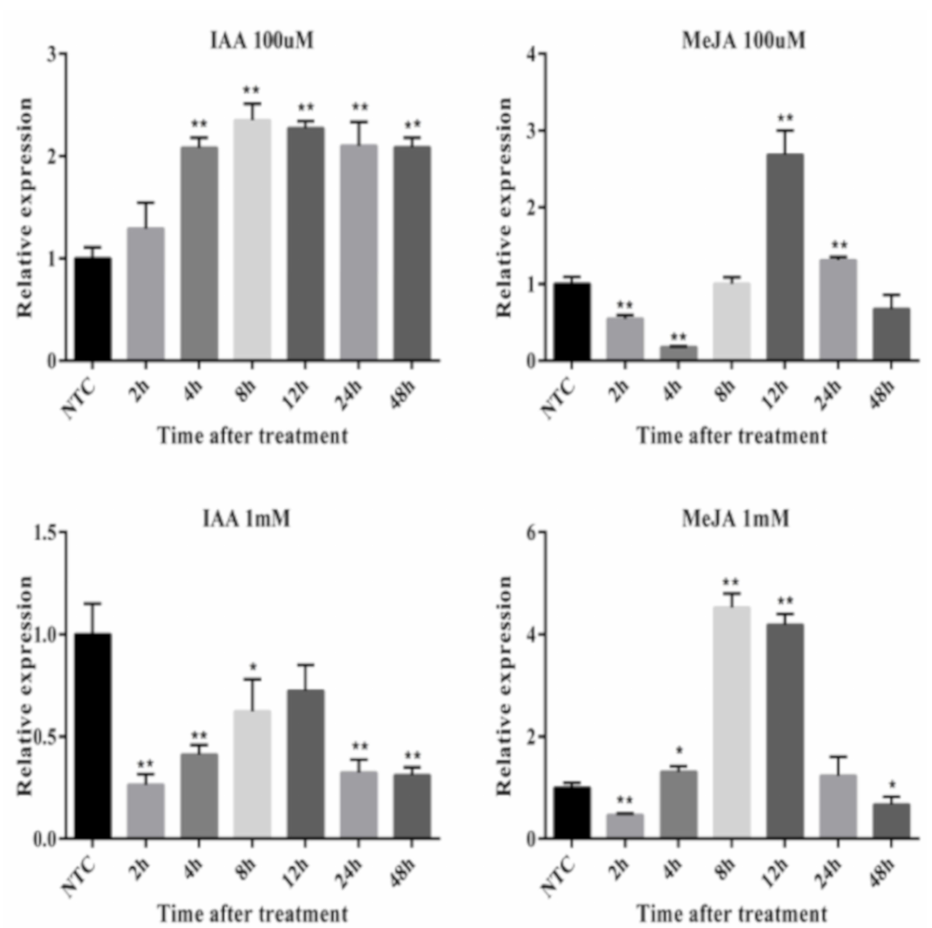
Figure 7. Expression analysis of ARC5 in response to hormonal treatment ( A ) The transcript level of ARC5 under 100 µ M IAA; ( B ) The transcript level of ARC5 under 100 µ M MeJA; ( C ) The transcript level of ARC5 under 1 mM IAA; and, ( D ) The transcript level of ARC5 under 1 mM MeJA. Values are the mean ± SD from three separate experiments. Asterisk (* significant and ** highly significant) denote significant variation ( p <